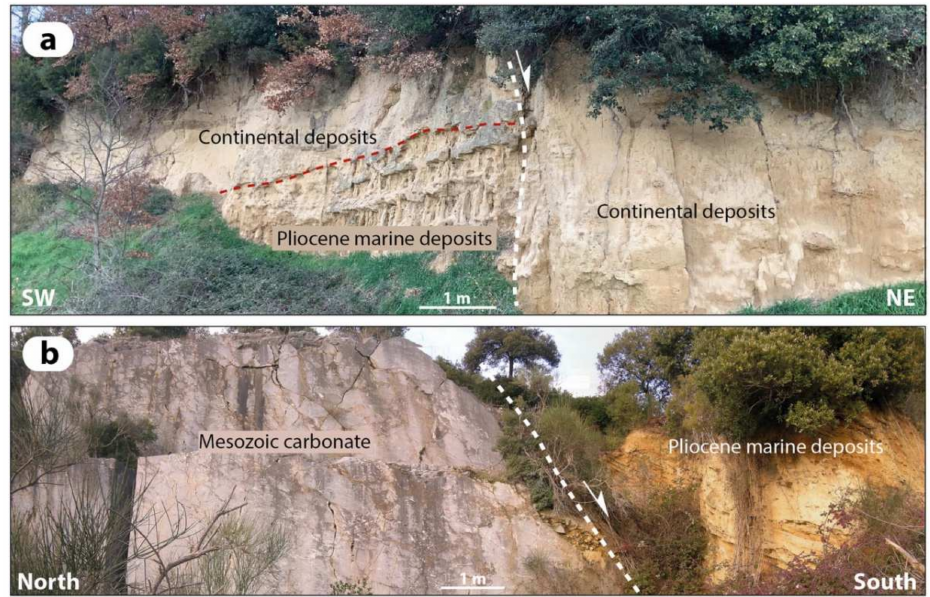
Figure 7. Panoramic view of faults affecting the successions filling the Sentino Basin and surround- ings: ( a ) NW-striking normal fault dissecting Late Pleistocene continental sediments; ( b ) NE-striking left-lateral oblique-slip fault juxtaposing Piacenzian marine deposits to Mesozoic